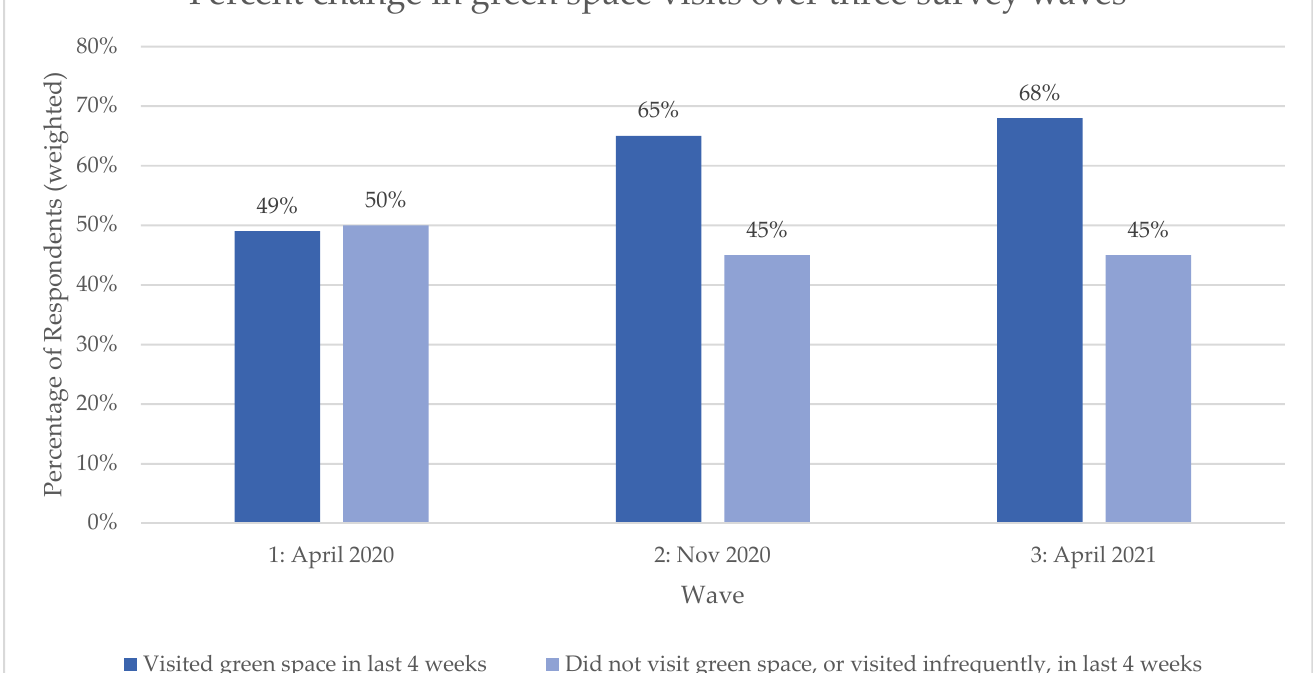
were weighted to account for survey response bias. ^ Infrequently defined as once every 2 weeks or once in the previous 4 weeks.